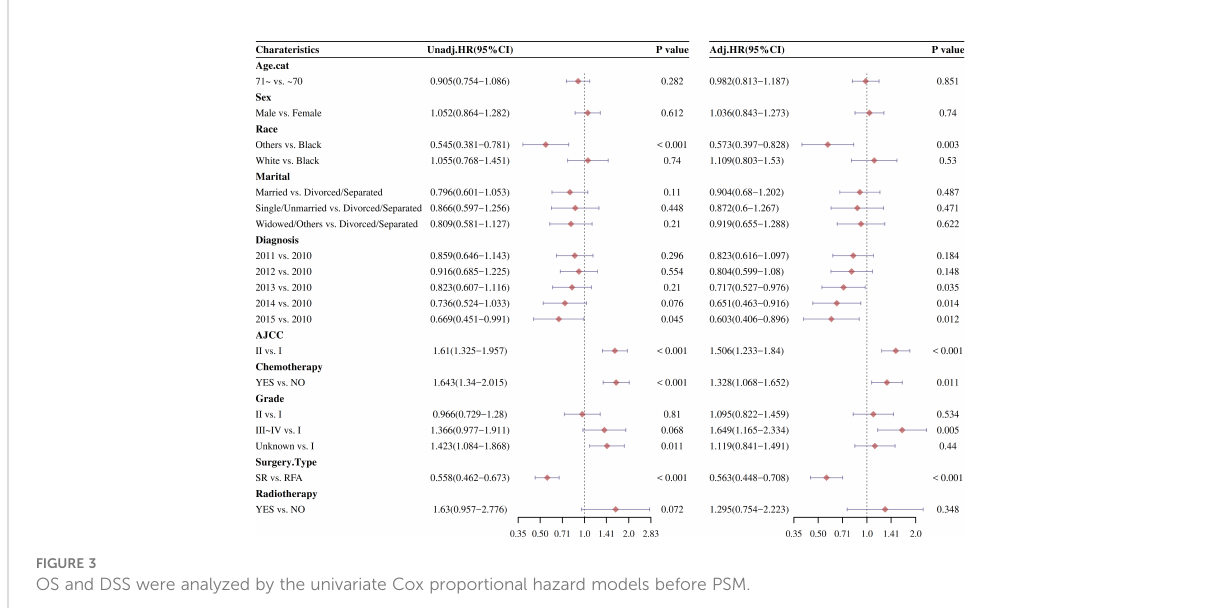
FIGURE 3 OS and DSS were analyzed by the univariate Cox proportional hazard models before